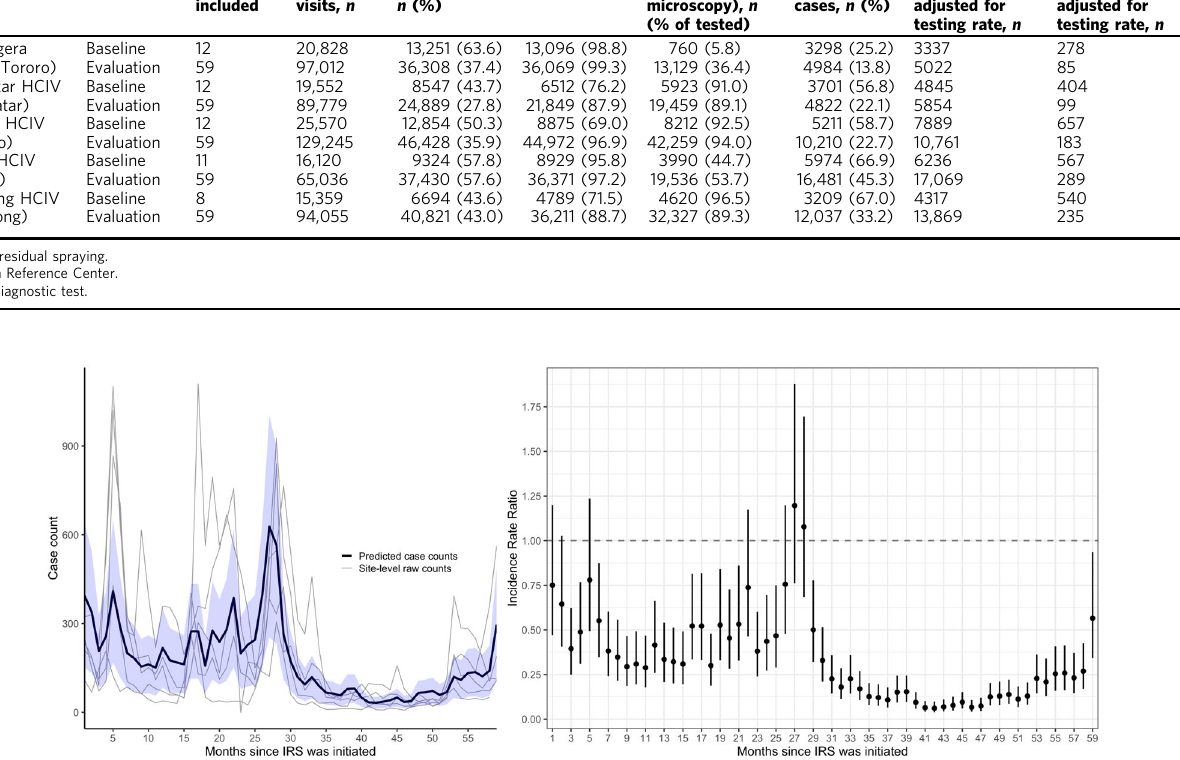
Table 3 Summary statistics from health-facility based surveillance sites where IRS a was initiated and sustained. MRC b (District) Time period Number of